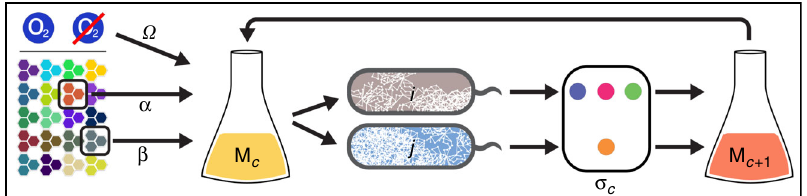
Fig. 1 Simpli fi ed schematic illustrating the in silico experiments. A growth medium ( M c ) containing two carbon sources ( α , β ) with or without oxygen ( Ω ) is provided to genome-scale metabolic models of two microbial organisms ( i , j ). If at least one organism grows, any costlessly secreted metabolites ( σ c ) are added to the medium, which is fed back to the organisms. This process is repeated for a series of iterations c , and terminates at iteration c s , de fi ned as the last iteration in which any new metabolites were secreted into